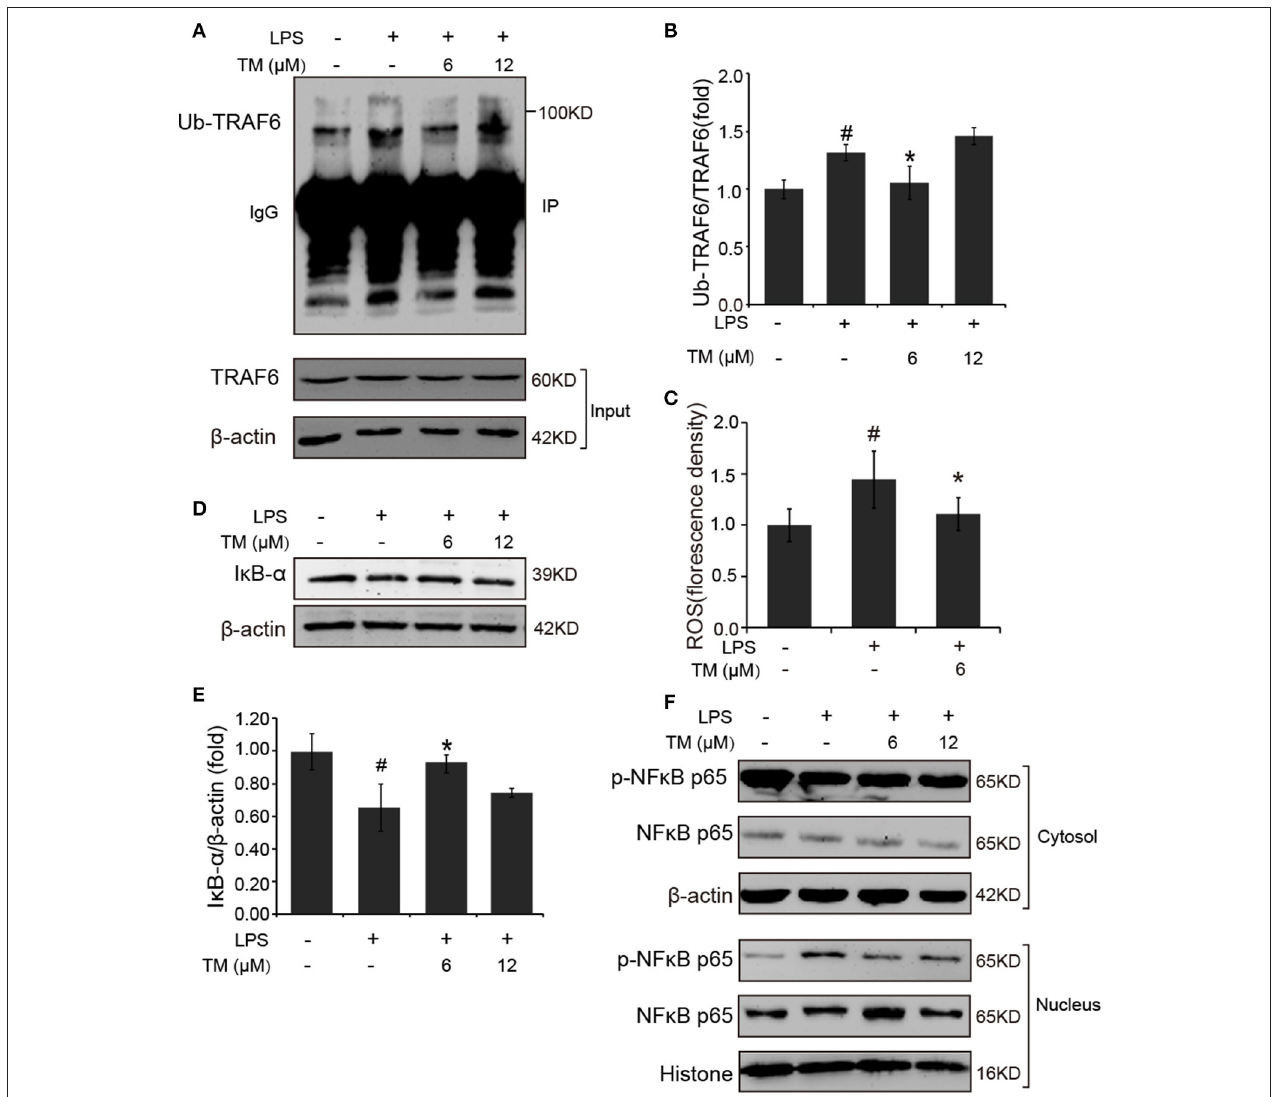
FIGURE 5 | TM-pretreatment reduces the ubiquitination of TRAF6 and decreases nuclear translocation of NF κ B by inhibiting the degradation of I κ B- α in LPS-induced BV-2 cells. After treated with TM and LPS, cell lysates were collected and immunoprecipitated with TRAF6 antibody, and the IP sample was detected with ubiquitin antibody. (A,B) Immunoblot images (A) and quantifications (B) show that TM-pretreatment lead to the decrease of TRAF6 ubiquitination. (C) ROS was detected by fluorescent enzyme analyzer. (D,E) Immunoblot images (D) and quantifications (E) show that I κ B- α expression was inhibited by LPS, but the inhibition was blocked by pre-treatment with TM. (F) Immunoblot images show that TM prohibited the nucleus localization of NF κ B induced by LPS. The results are represented as the mean ± SD of at least three independent experiments (N ≥ 3). * p < 0.05 compared with the LPS; # p < 0.05 compared with the control. The p- values were calculated by One-way ANOVA followed by Bonferroni’s post-hoc